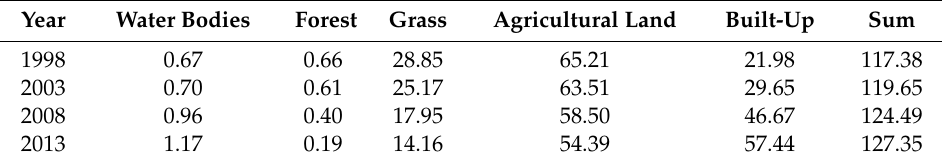
Table 12. Runo ff from SCS model in di ff erent districts in di ff erent periods (10 6 m 3